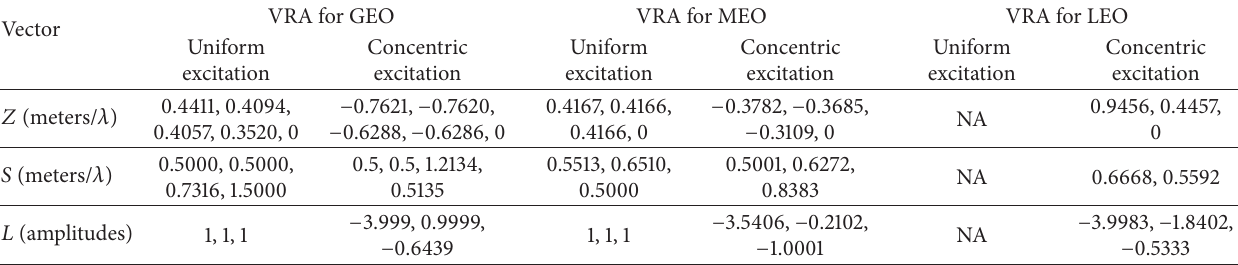
Table 1: Numerical values of antenna excitations and